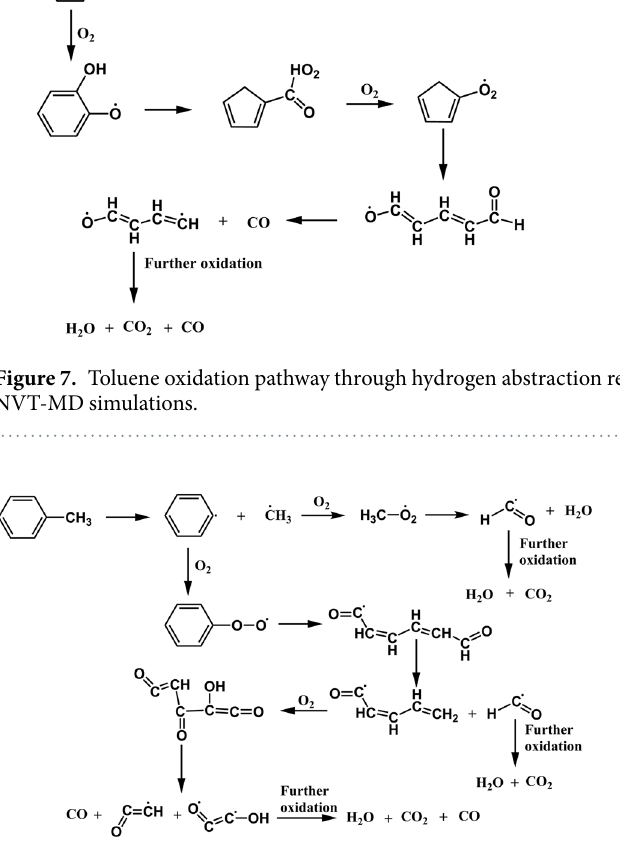
Figure 8. Toluene oxidation pathway through pyrolysis observed during ReaxFF NVT-MD simulations.